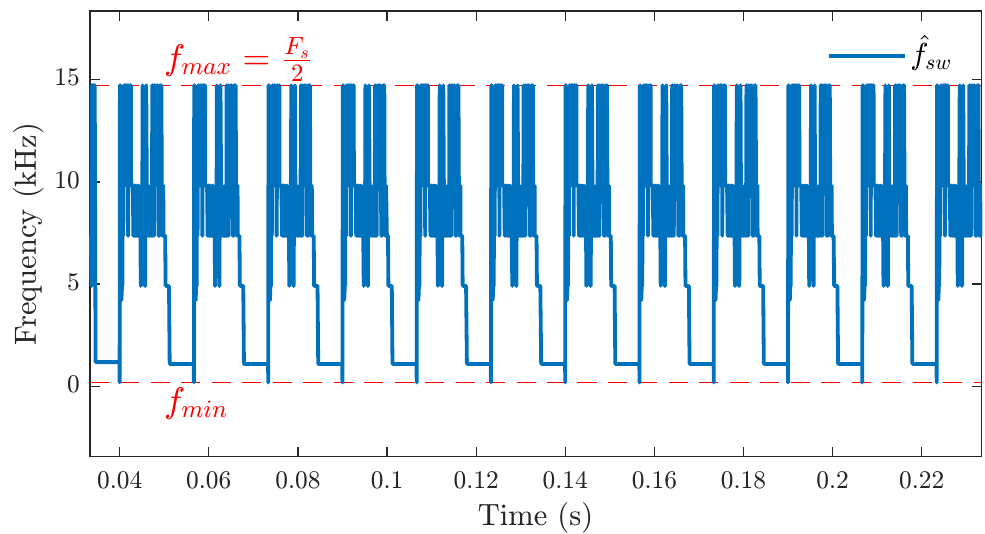
Figure 5. Instantaneous switching frequency FCS-MPC with sampling frequency equal to 29,460 Hz— calculated by Algorithm 1.